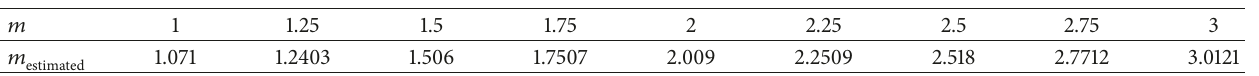
Table 1: Comparison between parameter 𝑚 value obtained by Matlab simulation over 𝑁 = 100000 samples of Nakagami- 𝑚 vector 𝑧 and value of 𝑚 parameter estimated by using (6) from this letter ( 𝑧 1 = mean (𝑧) , 𝑧 2 = mean (𝑧) − var (𝑧) , and Ω = 𝐸(𝑧 2 )) .